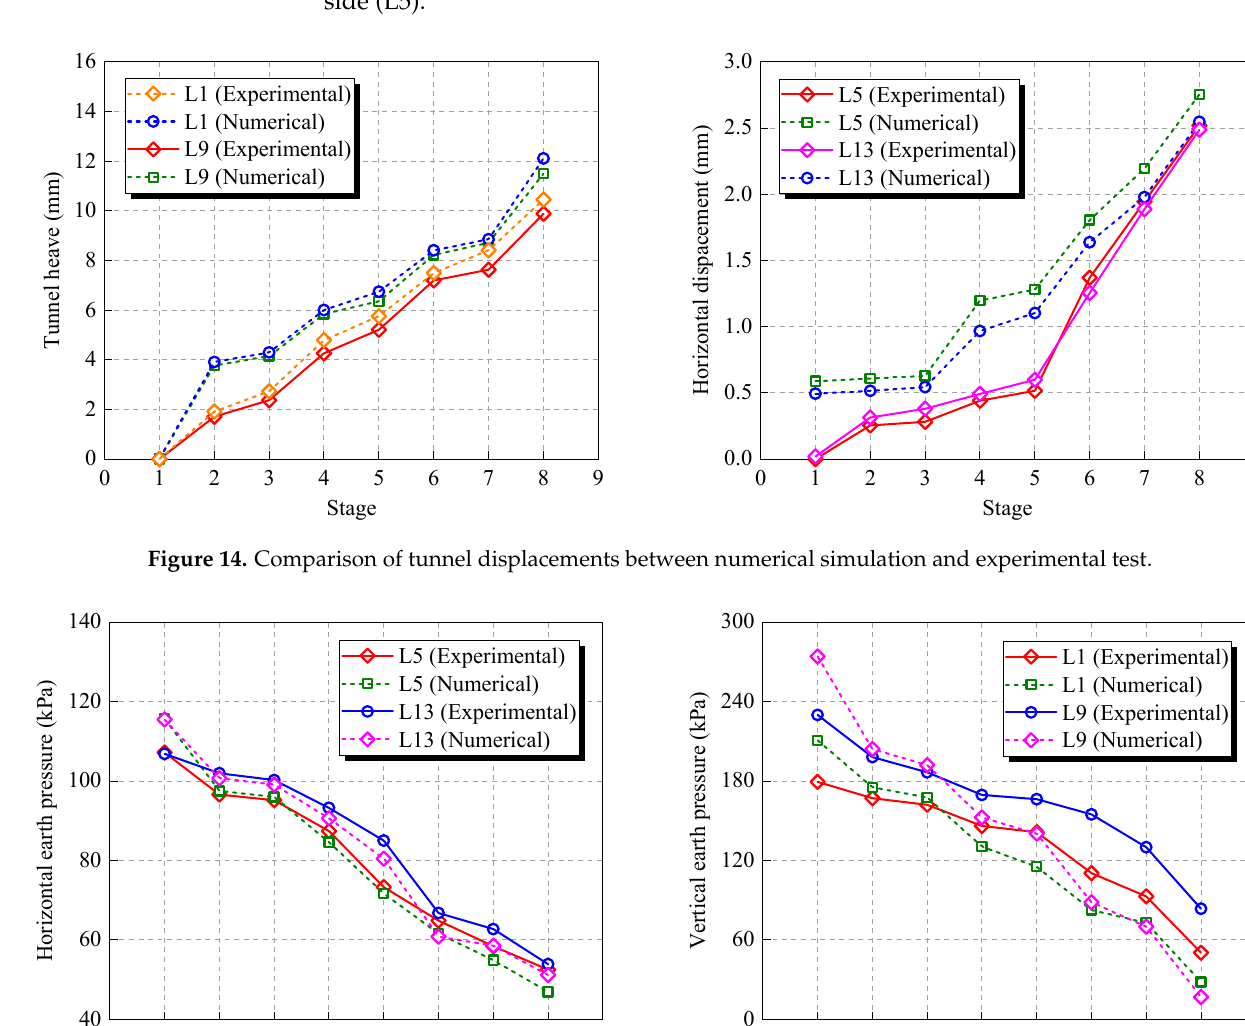
W p L p (b) Figure 13. 3D finite element mesh, ( a ) the whole mesh, ( b ) location relationship between foundation and twin-tube tunnels.